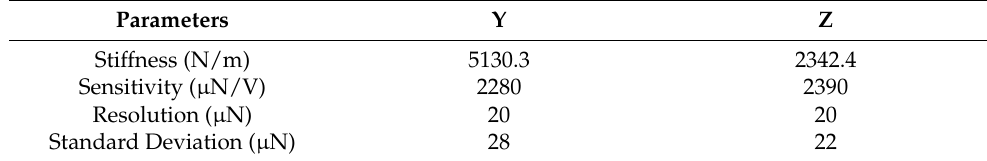
Table 4. PRT performance summary.